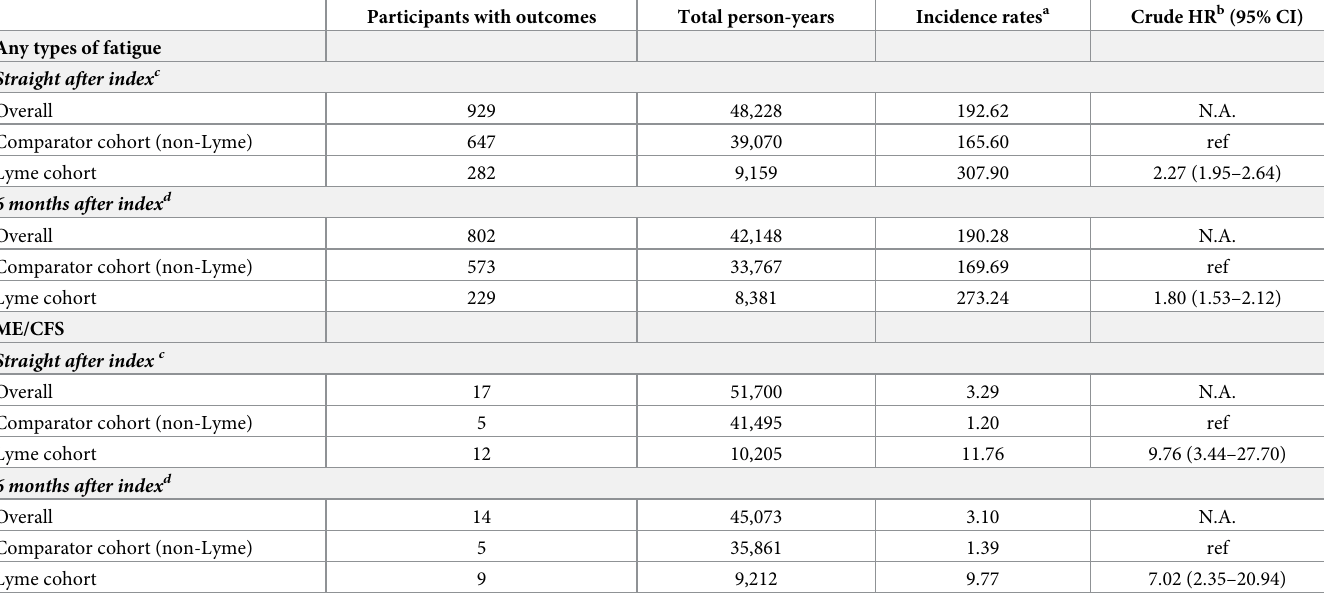
Table 3. Incidence rates and crude hazard ratios (HR) of any types of fatigue and ME/CFS for Lyme